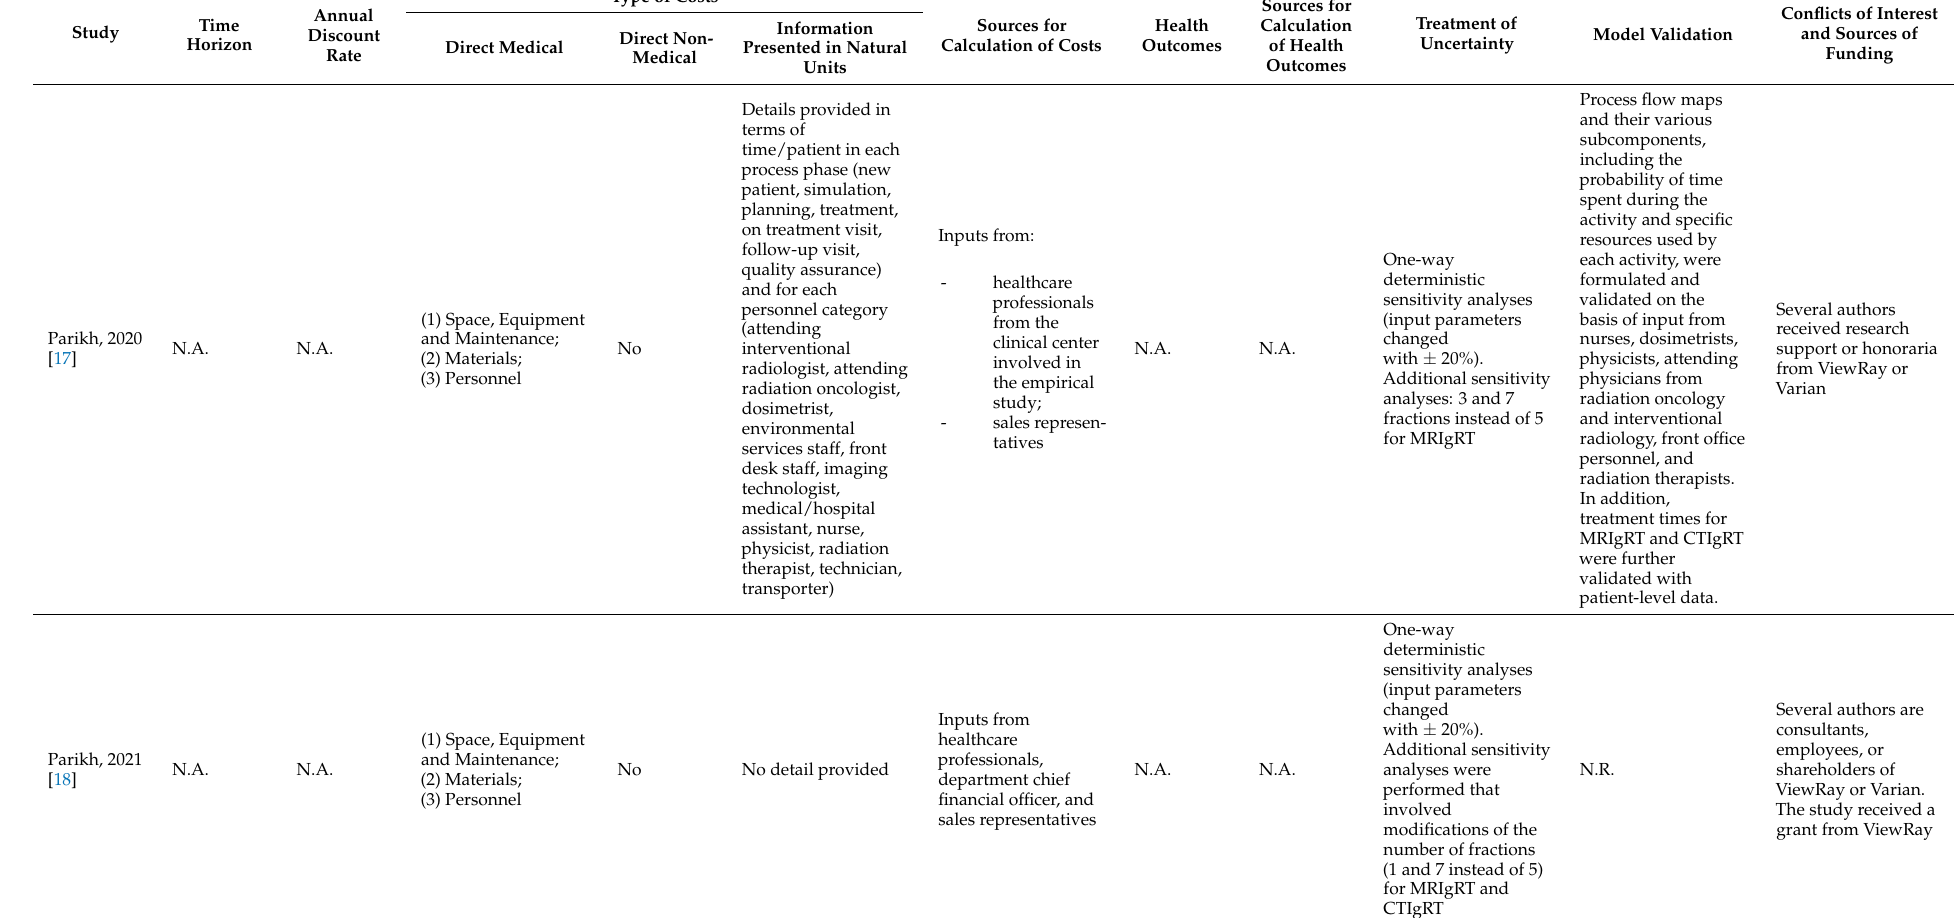
Table 2. Methodologies adopted in the